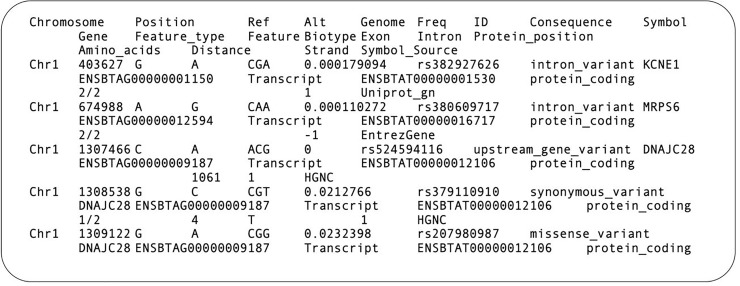
Example of meSNP database conformation, developed from the annotations contained in Run5 of the 1000 Bull Genomes Project and the Variant Effect Predictor.In the "Genome" column the second nucleotide represents the position of the meSNP in reference genome UMD3.1.1, described in the "Position" column; this nucleotide is also described in the "Ref" column. The "Alt" column represents the change caused by meSNP in the genomic sequence.